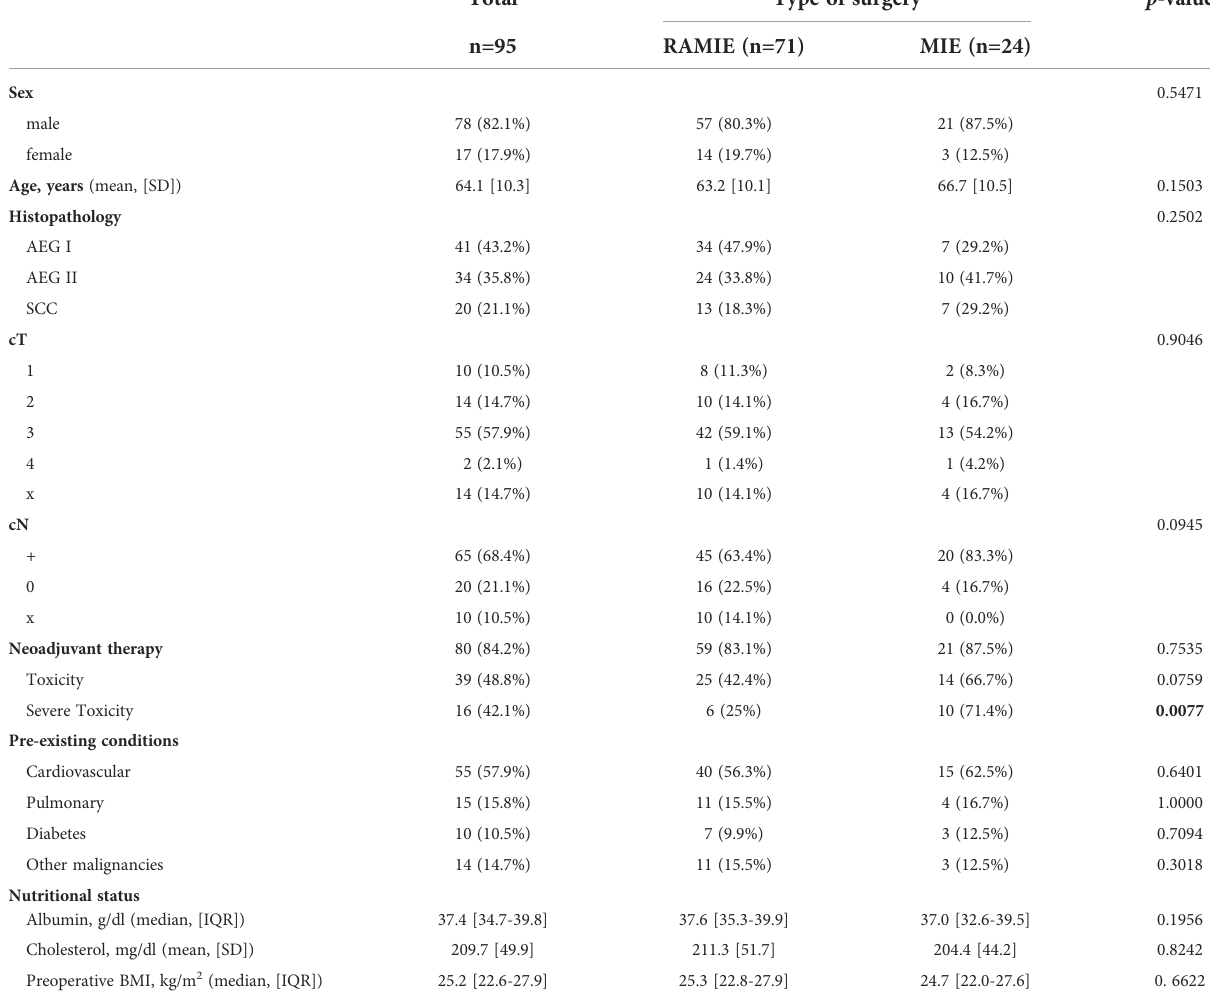
TABLE 1 Demographic and clinicopathological